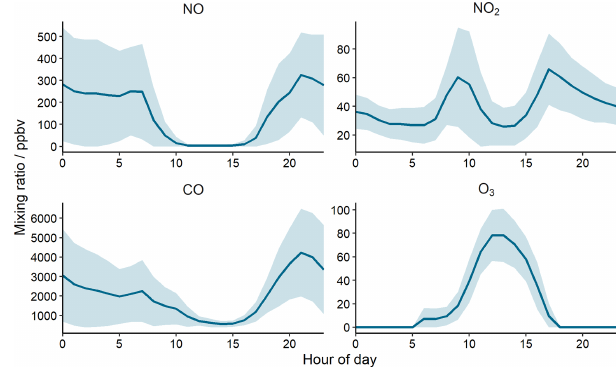
Figure 3. October campaign-averaged diel profiles. The shaded rib- bon represents the standard deviation of this average.